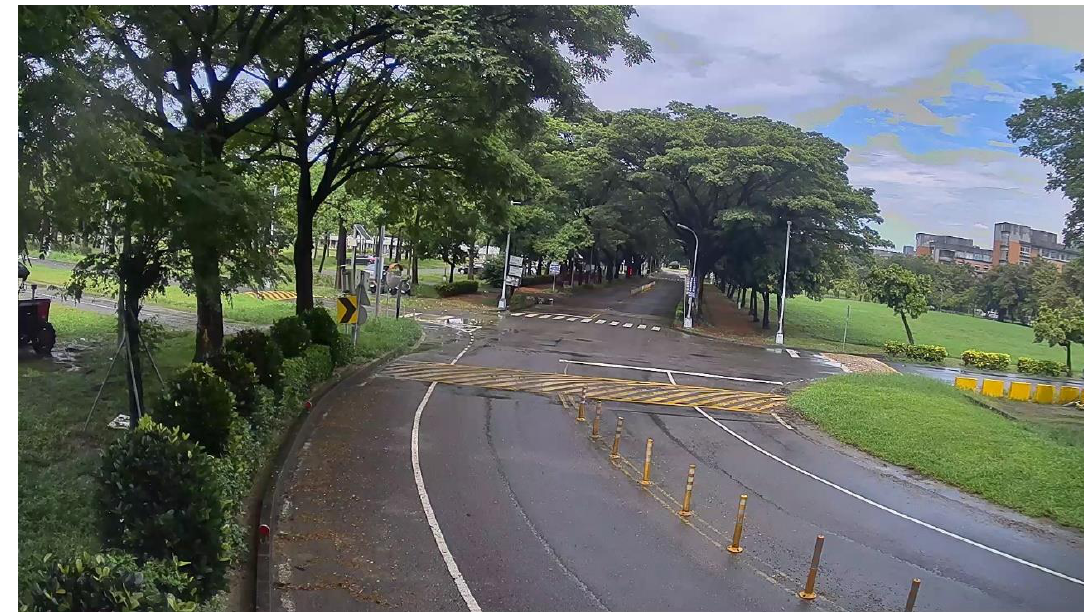
Figure 5. Sample image of the scene base frame.